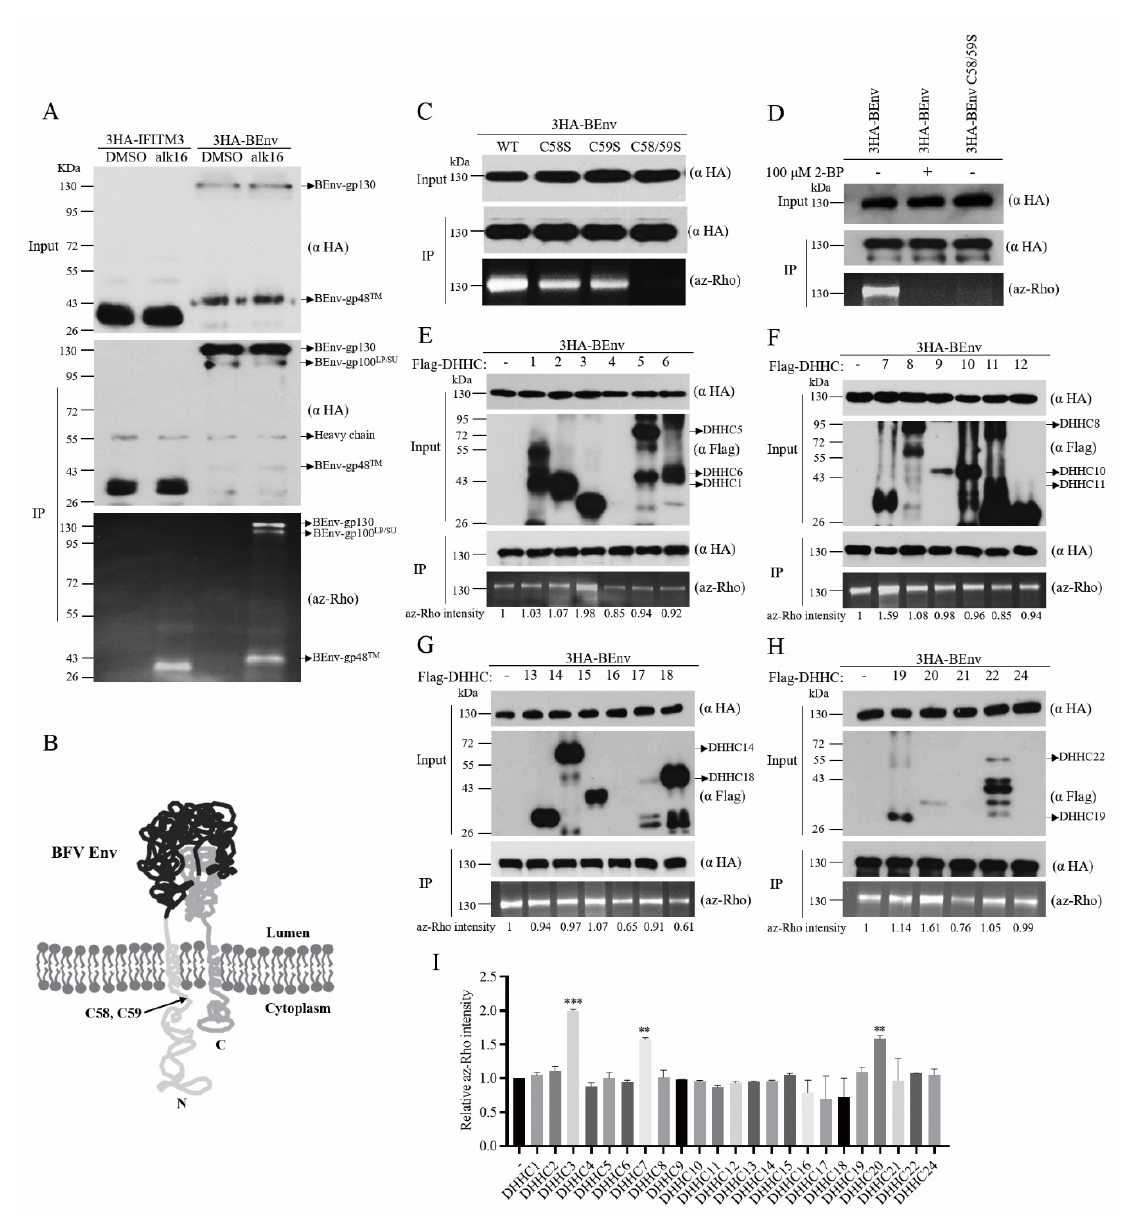
Figure 1. BEnv is palmitoylated at amino acid positions C58 and C59 by DHHCs. ( A ) HEK293T cells were transfected with 3HA-BEnv or 3HA-IFITM3 as the positive control of protein palmitoylation. Cells were treated with alk-16 or DMSO (negative control) for 2 h. The immunoprecipitated BEnv or IFITM3 were subjected to reaction with az-Rho via click chemistry. Levels of protein palmitoylation were determined by in-gel fluorescence scanning. ( B ) Membrane topology of the BFV Env. The palmitoylation sites C58 and C59 predicted by CSS-Palm version 4.0 are indicated. ( C , D ) Wild type BEnv or cysteine mutants (C58S, C59S, and C58/59S) lacking specific palmitoylation sites were transfected into HEK293T cells. Cells were labeled with alk-16 in the presence of 2-BP and lyzed prior to immunoprecipitation of BEnv and reaction with az-Rho via click chemistry for visualization of palmitoylation by fluorescence gel scanning. Western blotting was performed to confirm the comparable expression of both WT and mutant BEnv. ( E – H ) HEK293T cells were co-transfected with 3HA-BEnv and either control vector or different Flag-DHHCs. Cells were then metabolically labeled with alk-16. BEnv palmitoylation